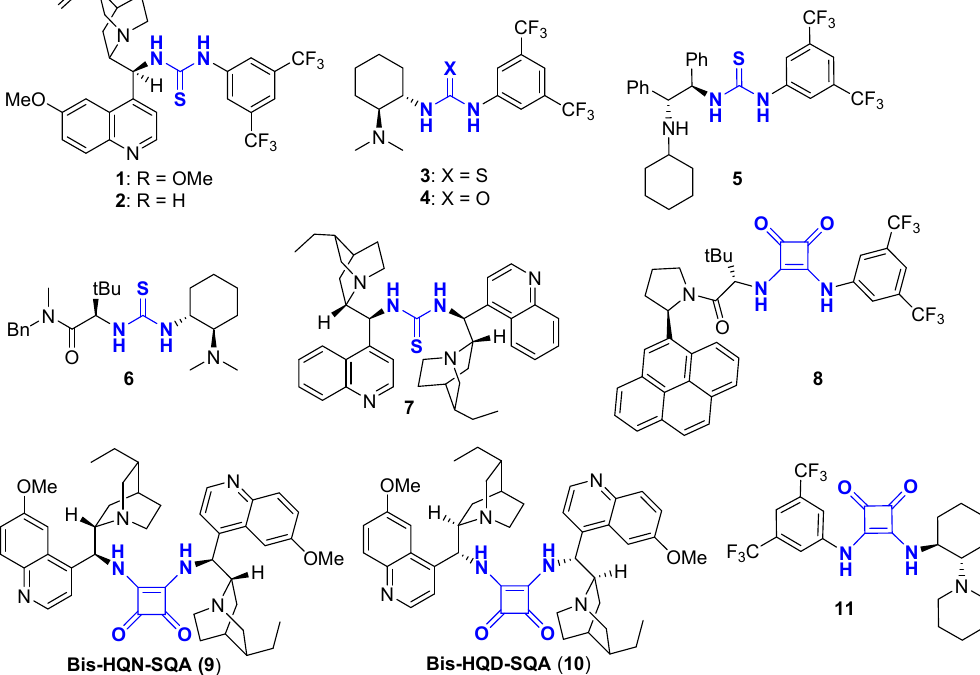
Figure 1. Selected reported representative (thio)urea and squaramide catalysts.